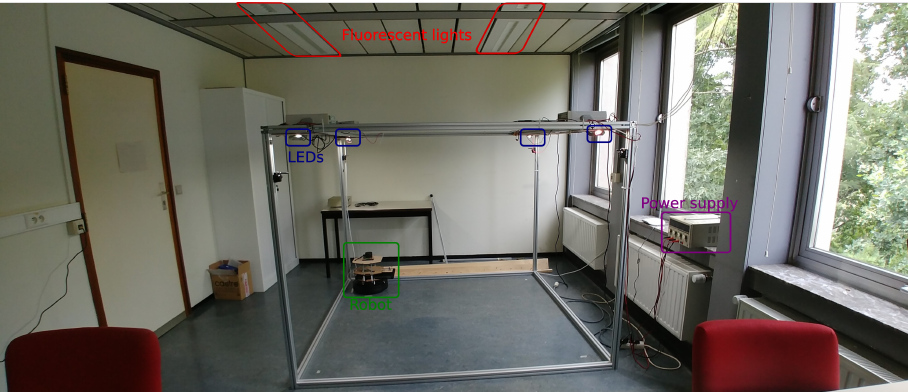
Figure 2. Experimental setup used in this paper, which was also used in our previous work [13,41]. Table 2. Hardware